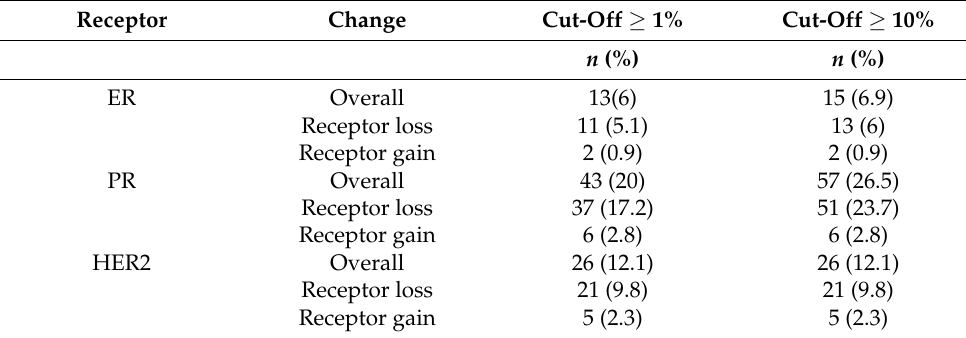
Table 3. Change of ER, PR and HER receptor status in t-CNB vs. LNM.